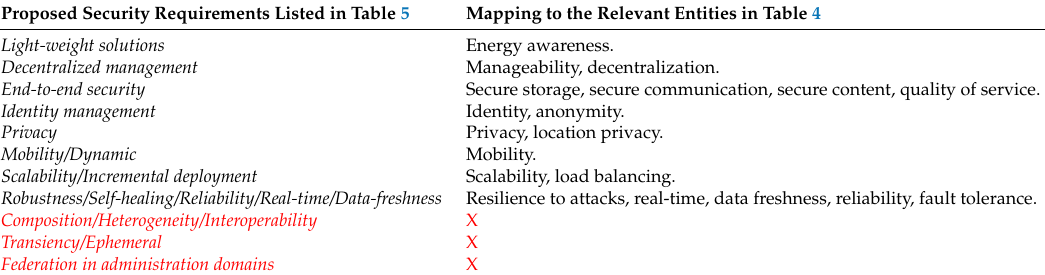
Table 6. The proposed requirements (left hand side) and the entities that they draw from Table 4 (right hand side). Proposed Security Requirements Listed in Table